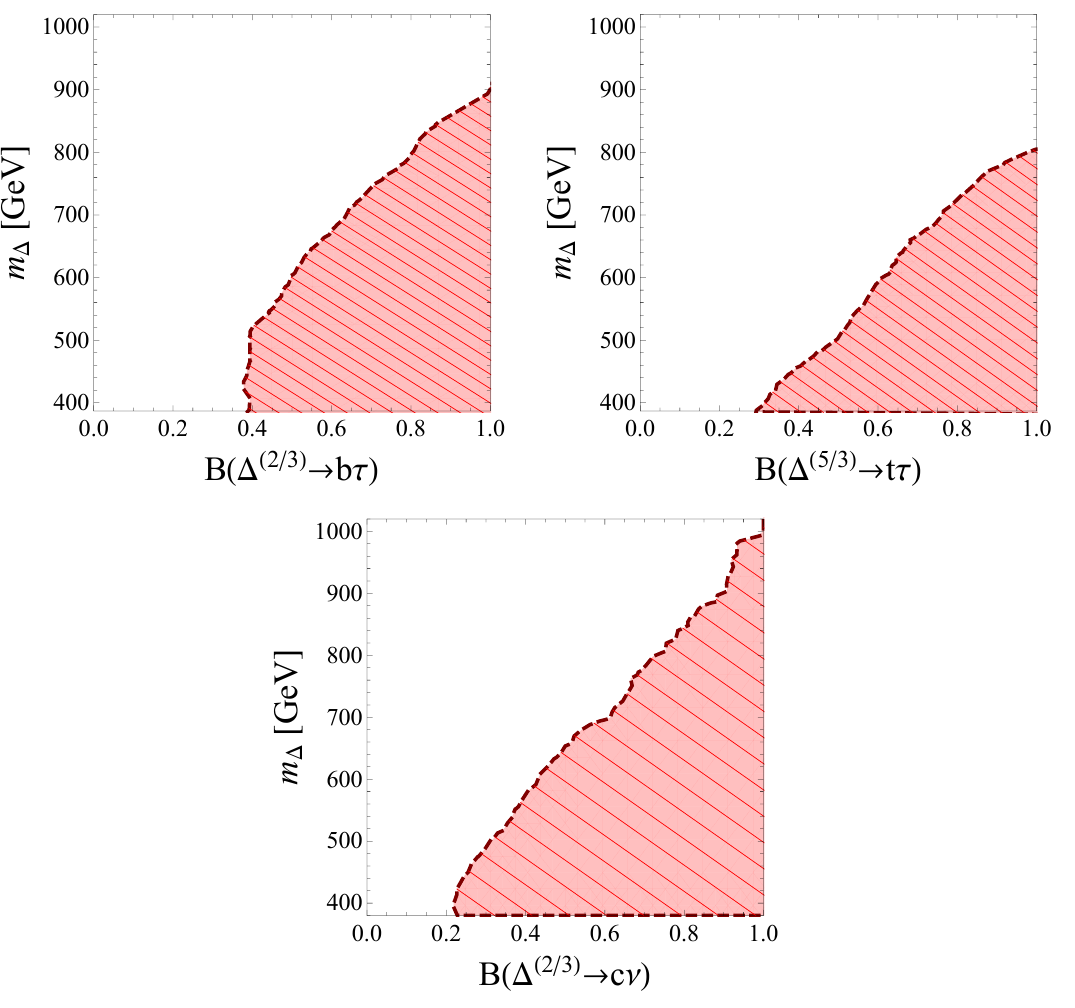
Figure 4 . Exclusion regions of m (cid:1) as a function of and ((cid:1) (2 = 3) c(cid:23) ) [74] at 95% CL. See text for details. B ! limits on m are shown in (cid:12)gure 4 as a function of (cid:1)